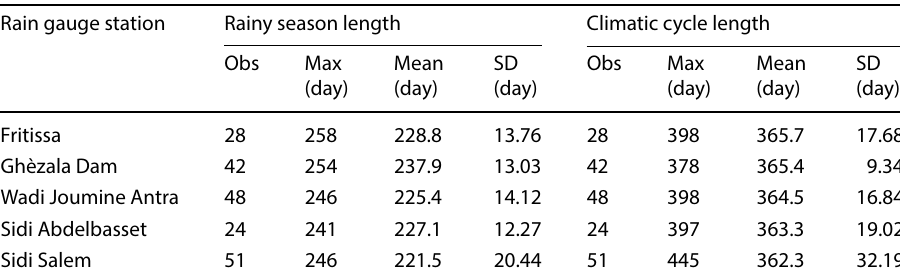
Obs observation, Max maximum, SD standard